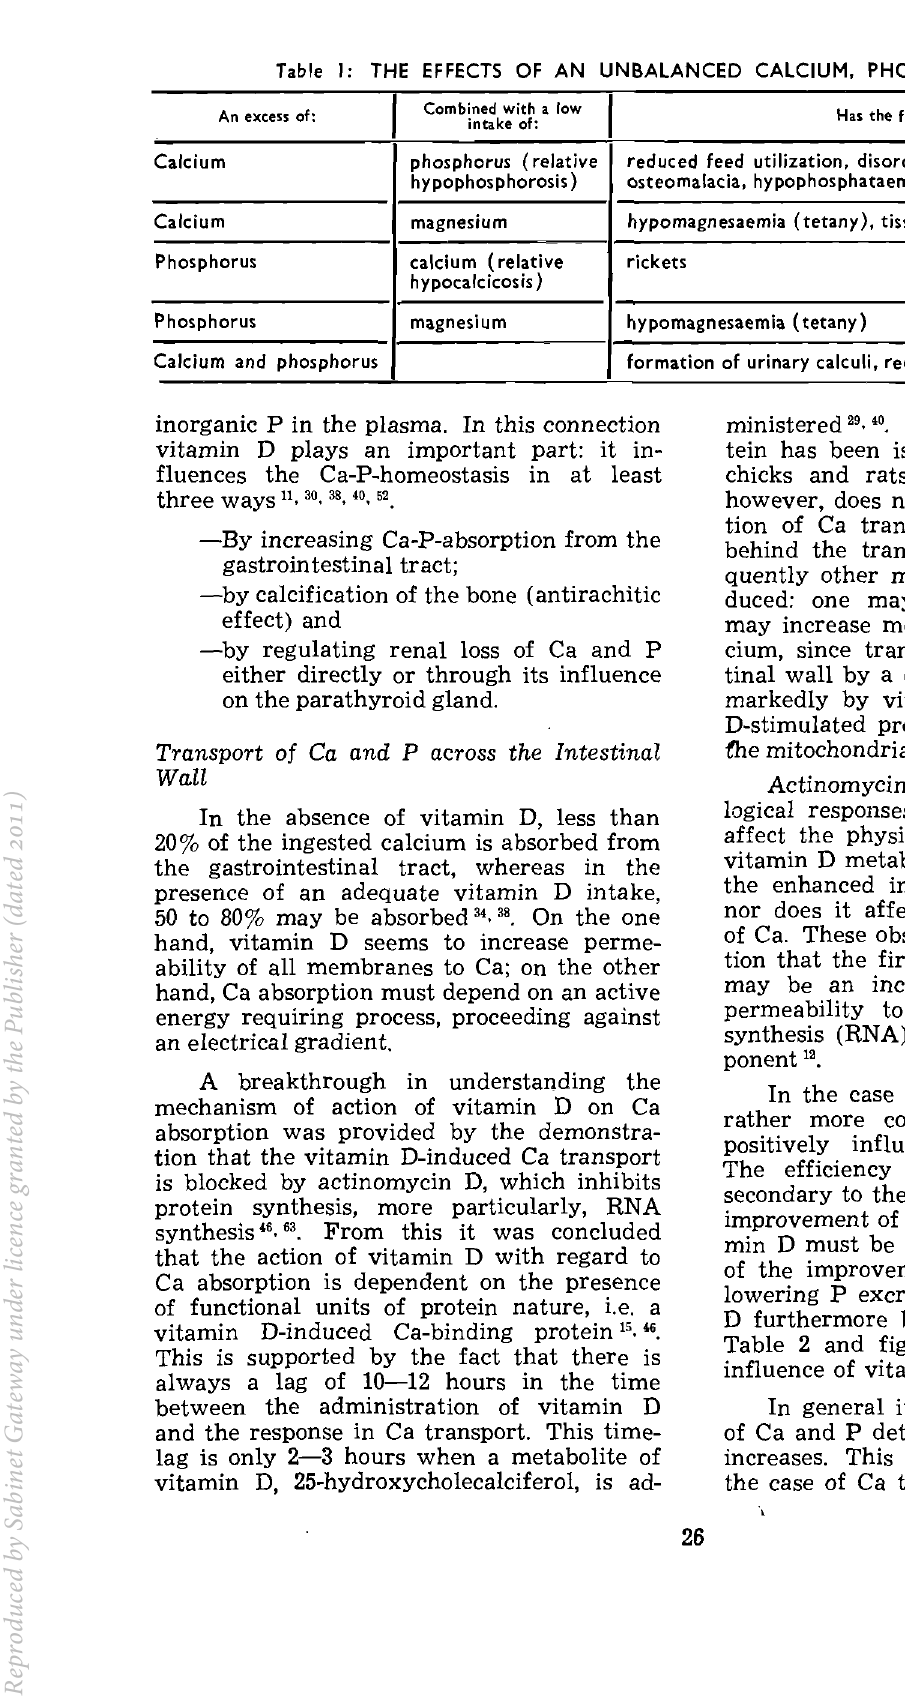
Table I: THE EFFECTS OF AN UNBALANCED CALCIUM, PHOSPHORUS SUPPLY